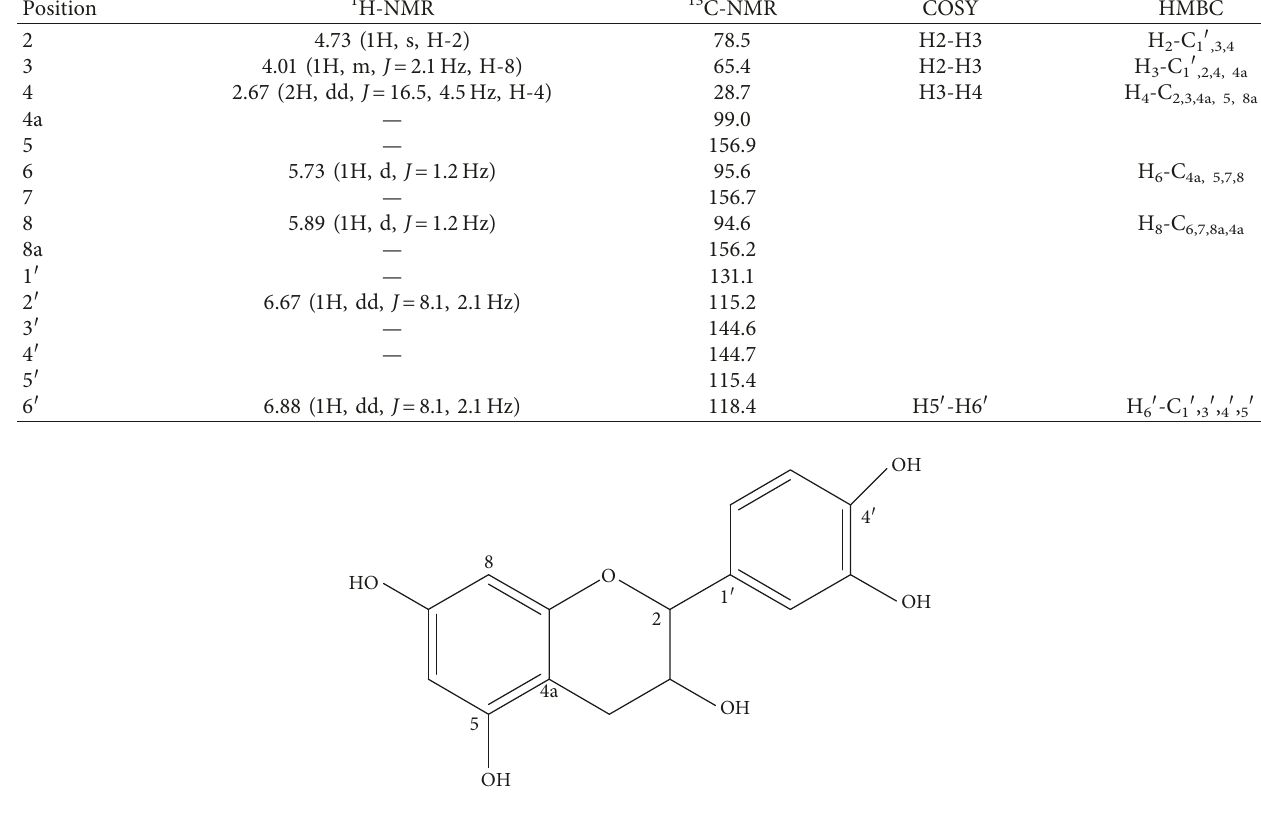
Table 2: 1 H-NMR, 13 C-NMR, and 2D spectral data of compound 1 in DMSO- d